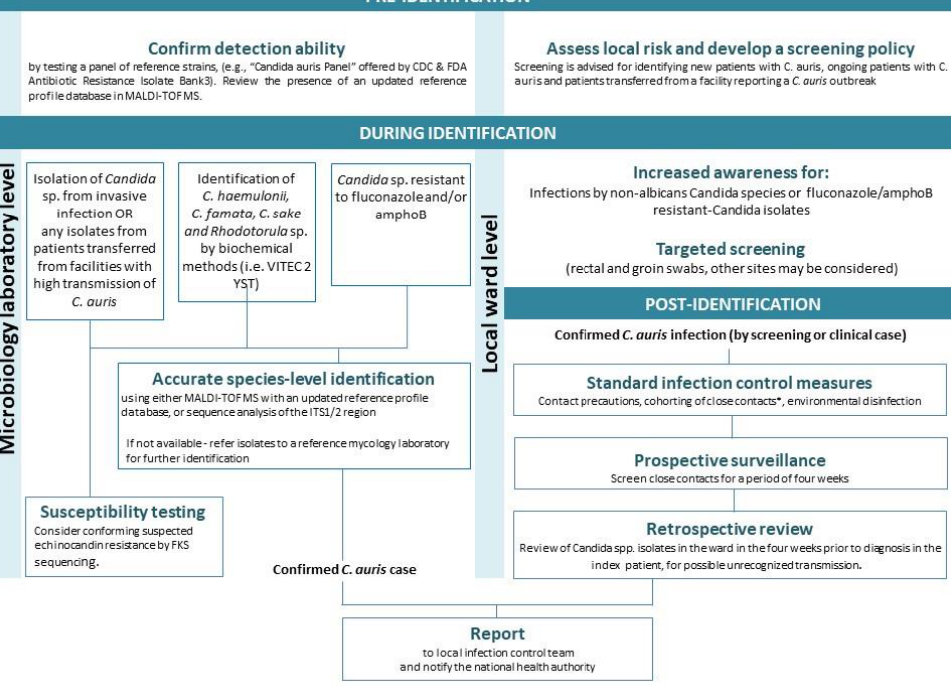
Figure 2. Recommended steps for preparedness and control of C. auris. The steps are based on recommendations of the US Centers of Disease Control and Public Health England [13,156]. See the text for complimentary recommendations. amphoB, amphotericin B; MALDI-TOF MS, Matrix-assisted laser desorption/ionization time-of-flight mass spectrometry; ITS1/2, internal transcribed spacer. * Close contacts can be de-isolated after three consecutive negative screens at least 24 h apart.